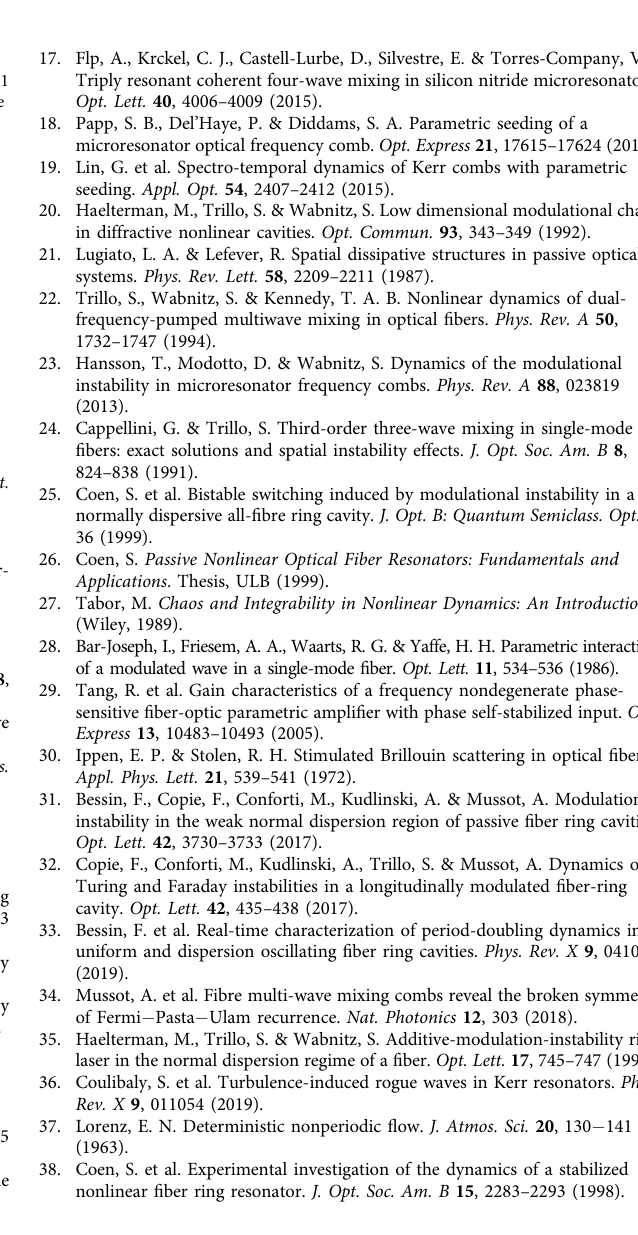
Fig. 7 Lorenz chaos in a fi ber resonator: numerics. a Steady-state curve for Δ = 3 (normalized cavity detuning). Dashed black, solid black, and solid blue curves stand for the cw unstable states, stable states, and modulationaly unstable states, respectively. b Trajectory of the dynamics of the system in the phase plan ( P s (signal power), ϕ s − ϕ 0 (pump-signal signal phase difference)) for Δ ξ = 0 (relative input phase) rad, corresponding to the con fi guration marked by the red dot in ( a ). P stands for output power, P in for input power, and CW for